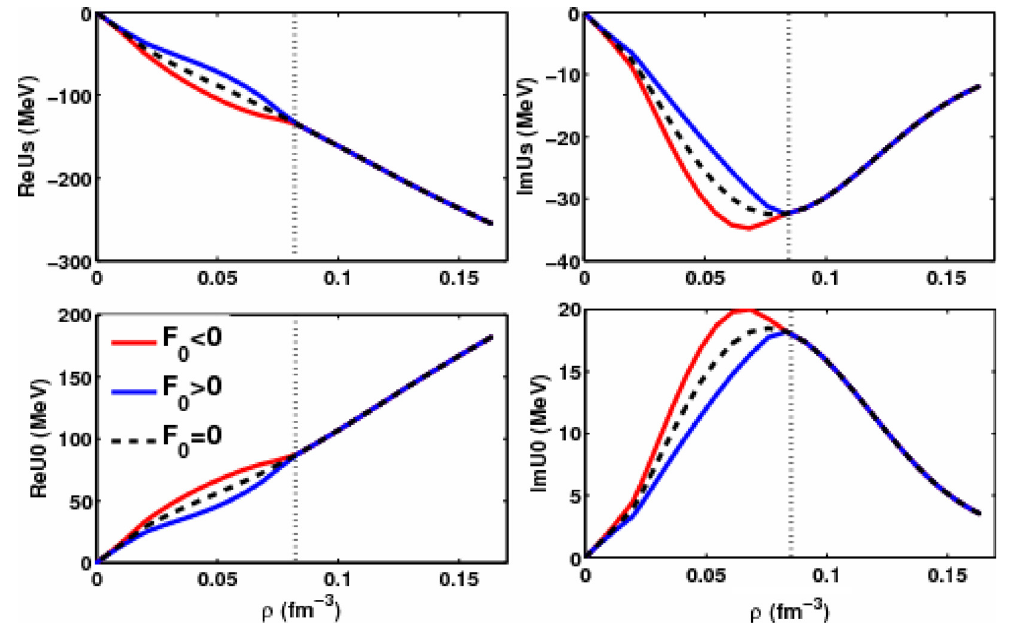
Fig. 3. The perturbation for Us and U 0 in this work.